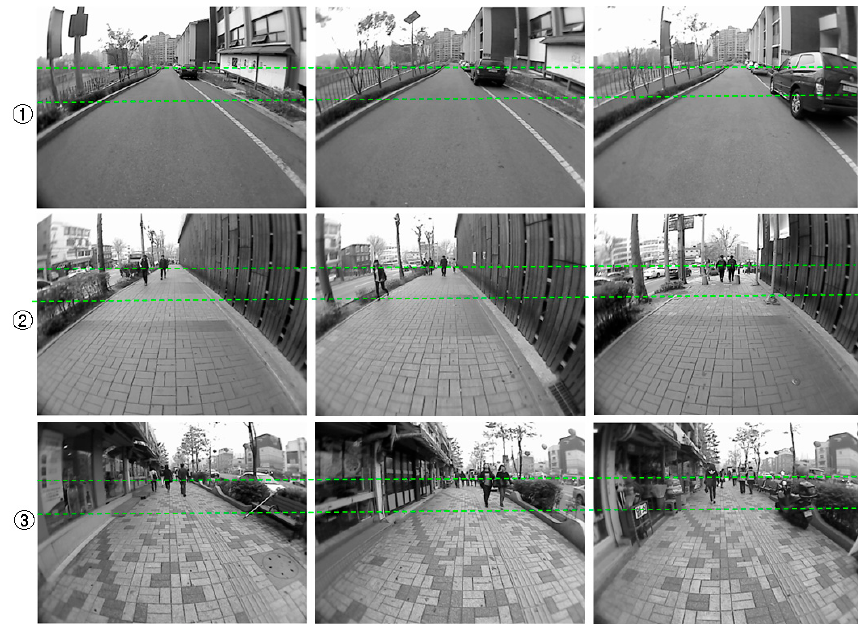
Figure 19. Sample images from the test scene.